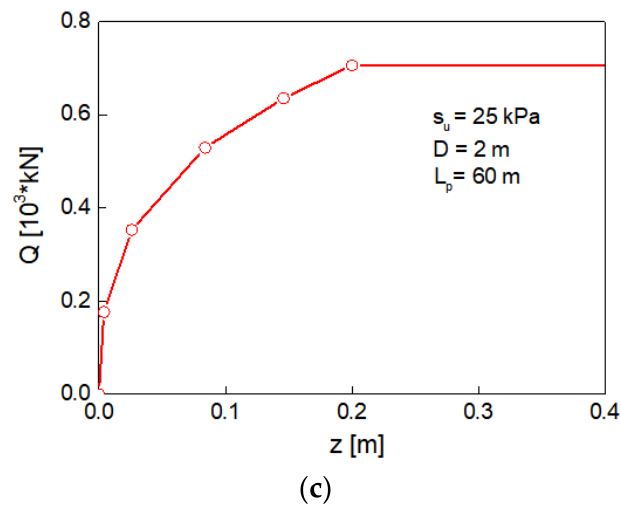
Figure 6. Nonlinear soil springs in this study, ( a ) p ‐ y curve, ( b ) t ‐ z curve, ( c ) Q ‐ z curve.